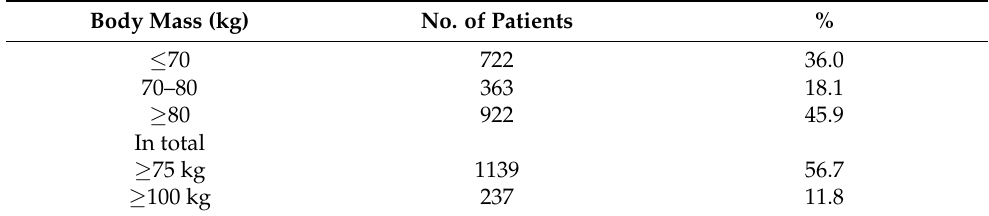
Table 1. The number and the percentage of patients with body mass classified within five